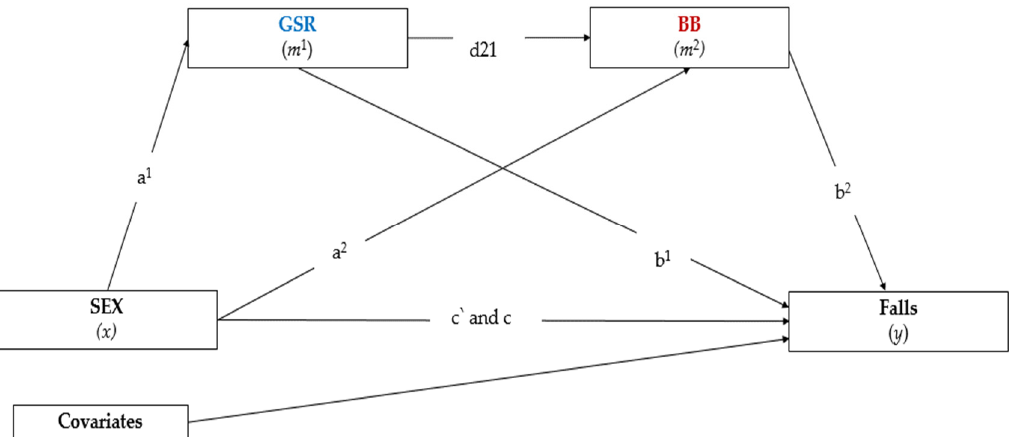
Figure 1. Path (a 1 ) = association between independent variable sex ( x ) with GSR mediator ( m 1 ), path (a 2 ) = association between independent variable sex ( x ) with BB mediator ( m 2 ). Path (b 1 ) = association between mediator GSR ( m 1 ) with dependent variable Falls ( y ), path (b 2 ) = association between mediator BB ( m 2 ) with dependent variable Falls ( y ), and path (d21) = association between both mediators GSR and BB ( m 1 and m 2 ). Path (c’) = association between independent variable Sex ( x ) with dependent variable Falls ( y ), and Path (c) = total indirect effect through paths a 1 , b 1 , a 2 , b 2 , and d21.